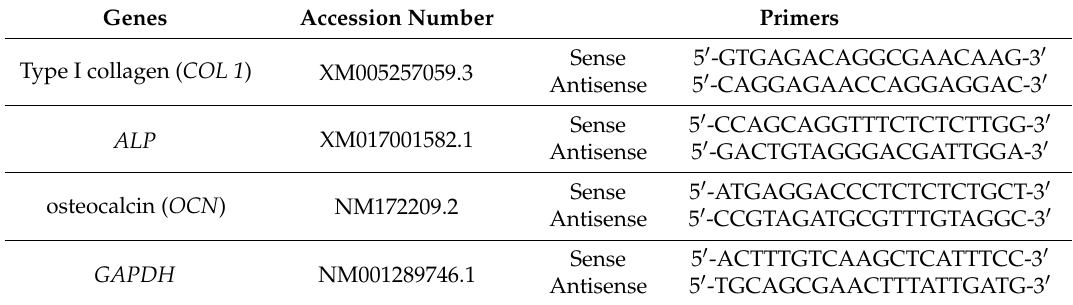
Table 1. Accession numbers and primers of type I collage ( COL 1 ), ALP , osteocalcin ( OCN ), and glyceraldehyde 3-phosphate dehydrogenase ( GAPDH ) mRNA genes used for this study. Genes Accession Number Primers Type I collagen ( COL 1 )